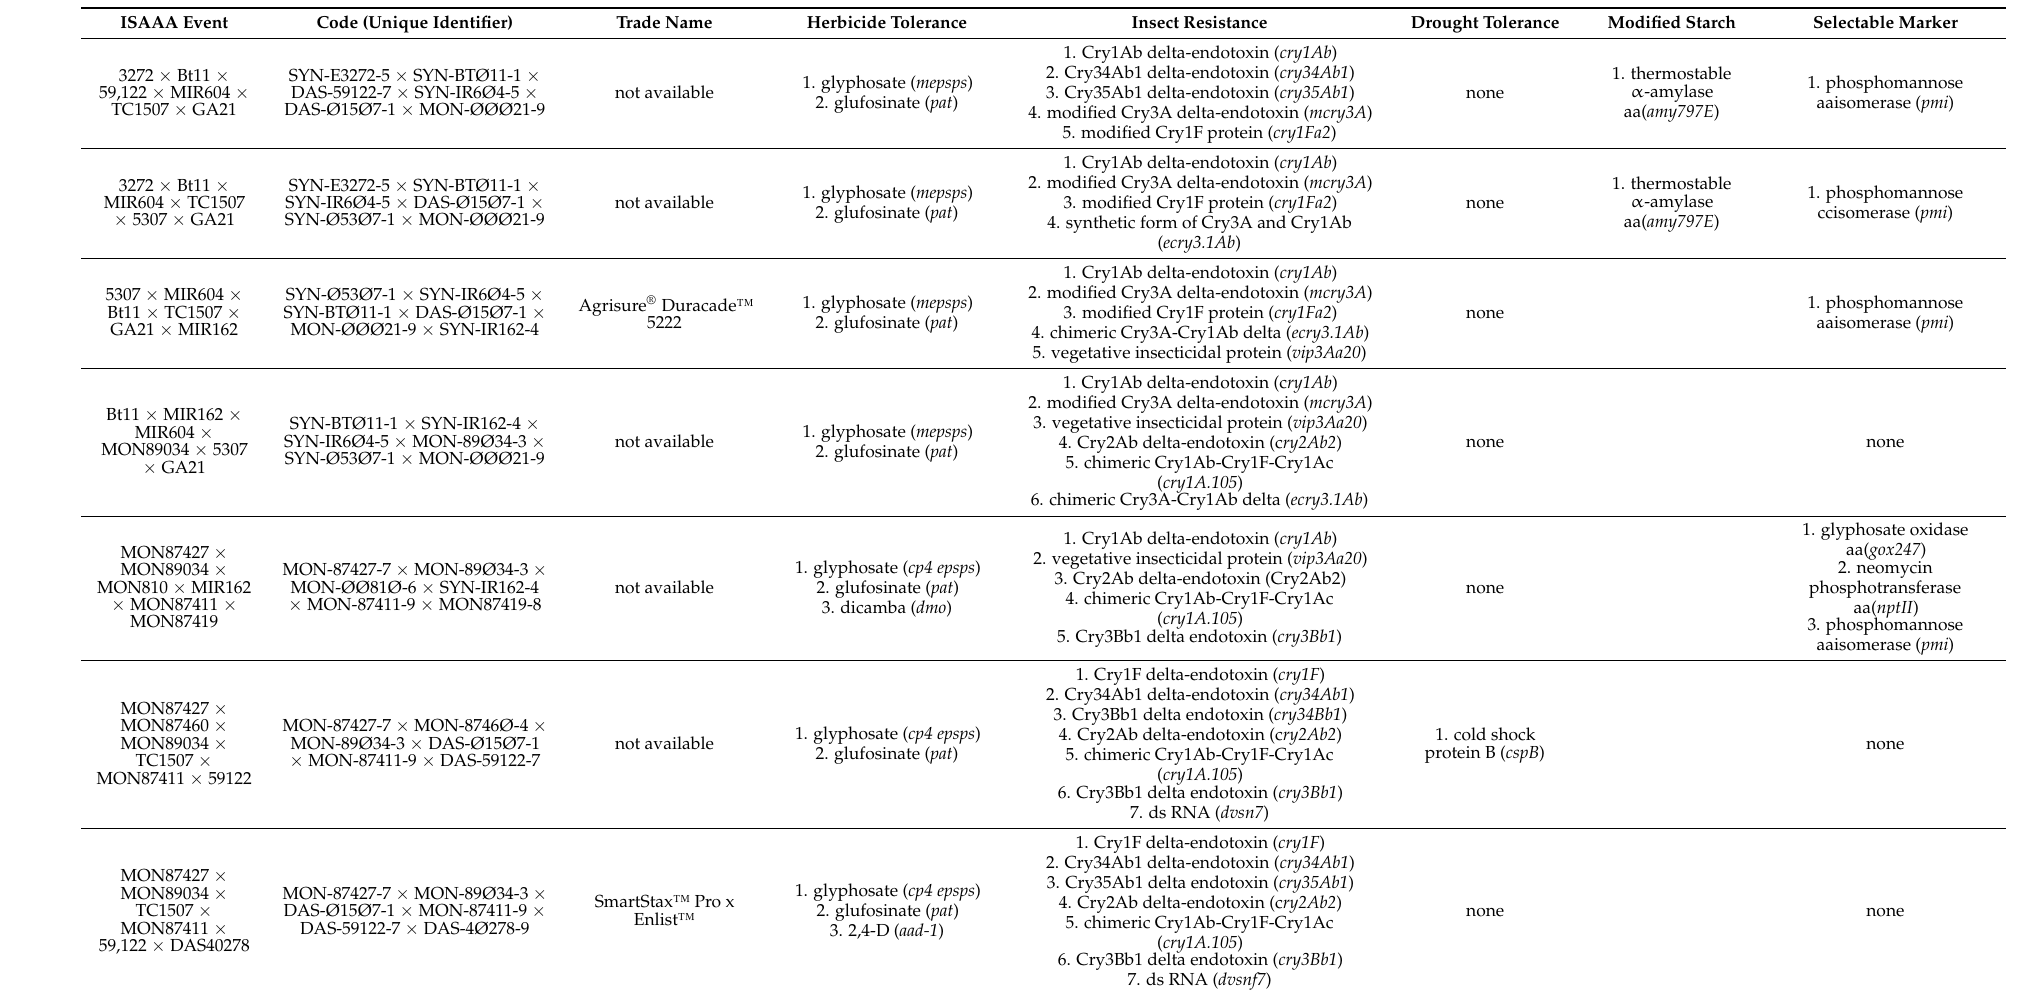
Table 1. Transgenic six-stacked maize varieties in commercial use